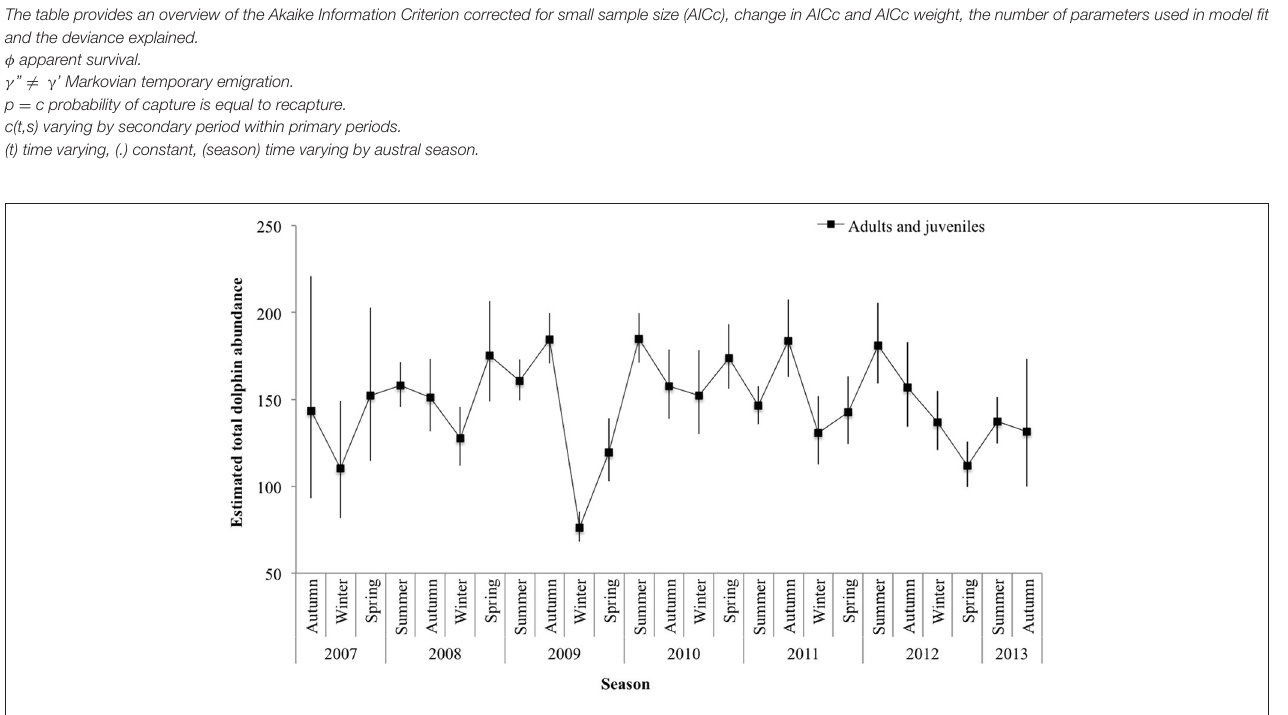
The table provides an overview of the Akaike Information Criterion corrected for small sample size (AICc), change in AICc and AICc weight, the number of parameters used in model fit and the deviance explained. φ apparent survival. γ ” 6= γ ’ Markovian temporary emigration.